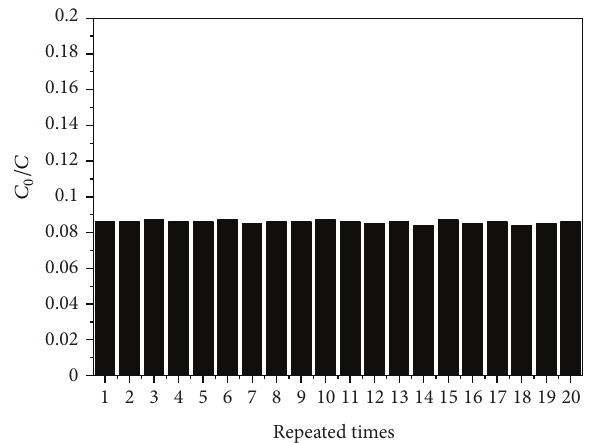
Figure 8: The reusability of the catalyst (20mg/L of MO aqueous solution, initial pH = 2.1, 1.0 g/L of Fe-TNT-1, illumination 1